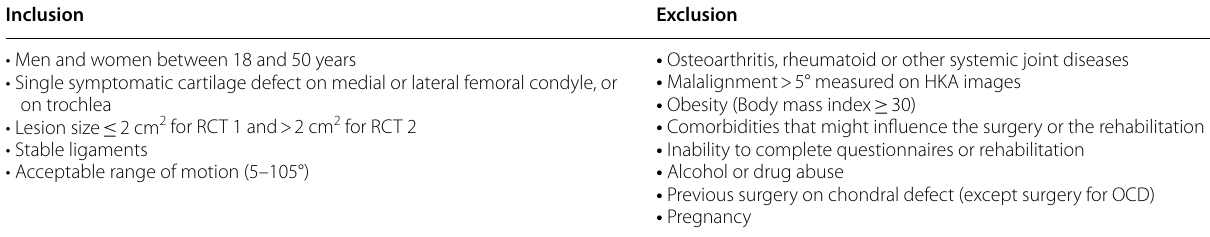
Inclusion and exclusion criteria for the Norwegian Cartilage Project and the current study